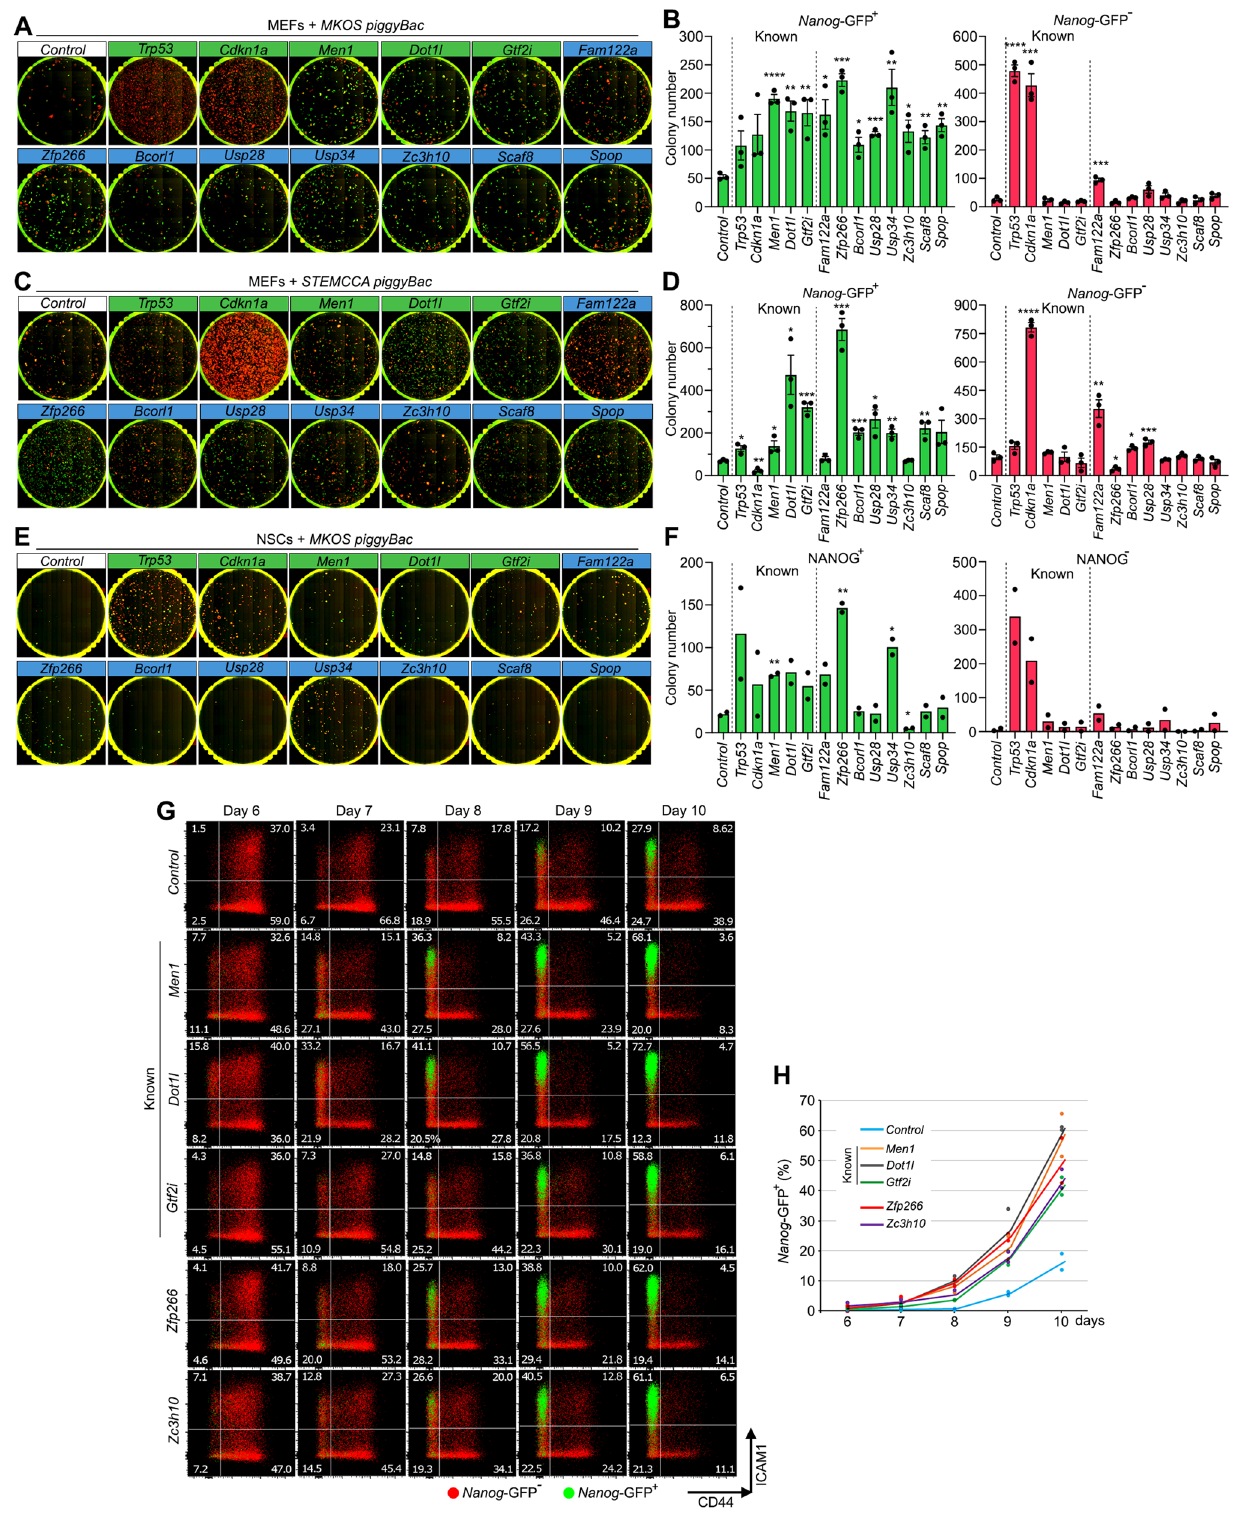
Fig. 2|Characterizationoftheroadblock geneKOindifferentreprogramming systems and kinetics. A , C Cas9 expressing Nanog -GFP MEF reprogramming with MKOS (A), STEMCCA (C) piggyBac transposons with sgRNA expression at day 15. Red; mOrange, Green; Nanog -GFP. B , D Nanog -GFP + and Nanog -GFP - mean colony numbers from A and C . The graphs in B and D represent an average of three independent experiments. E Cas9 expressing NSC reprogramming with MKOS piggyBac transposons with sgRNA expression at day 15. Green; immuno- fl uorescence for NANOG. F NANOG+and NANOG- mean colony numbers from E .